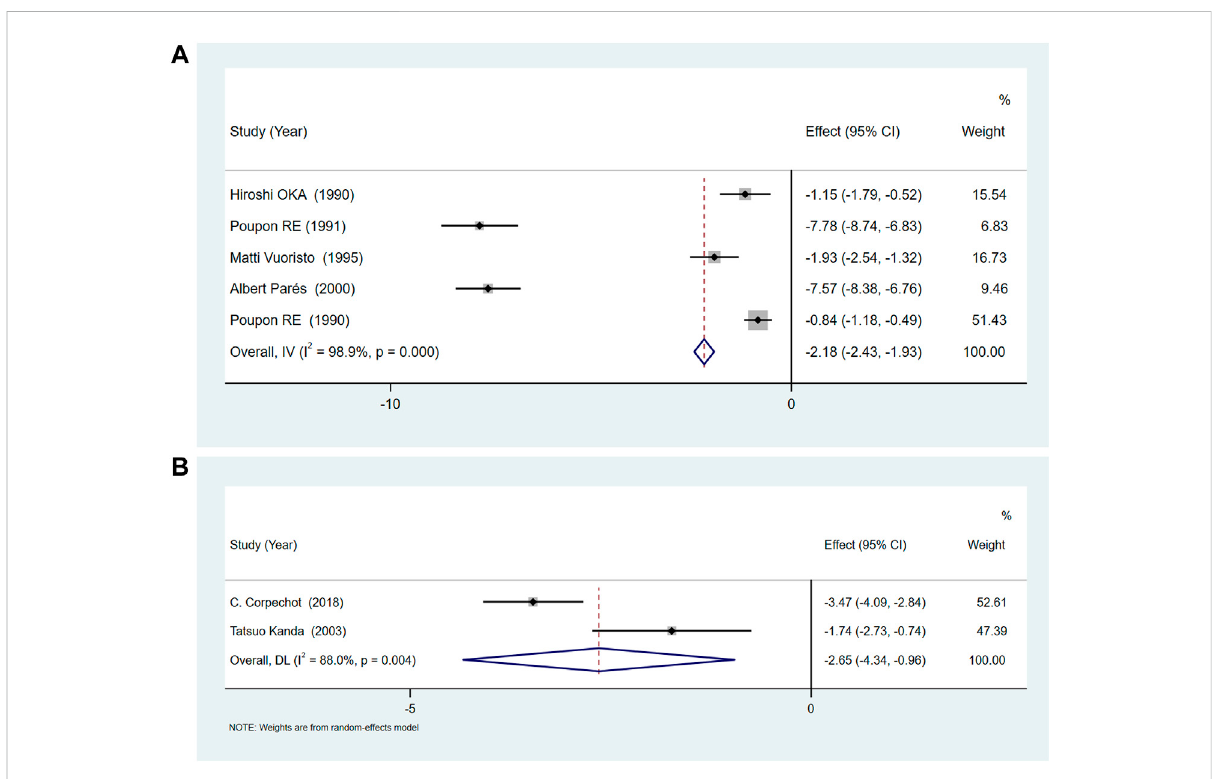
FIGURE 5 (A) The effect of UDCA on serum γ -GGT. (B) The effect of Beza fi brate on serum γ